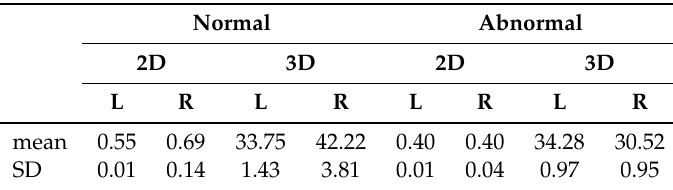
Table 1. The means and standard deviations (SDs) of n − 1 ∑ n the subjects in Figures 2 and 7 based on 27 different settings of ( c 1 , c 2 , ω ) in (8), where c 1 = 0.8,1.0,1.2, c 2 = 1.6,2.0,2.4, and ω =